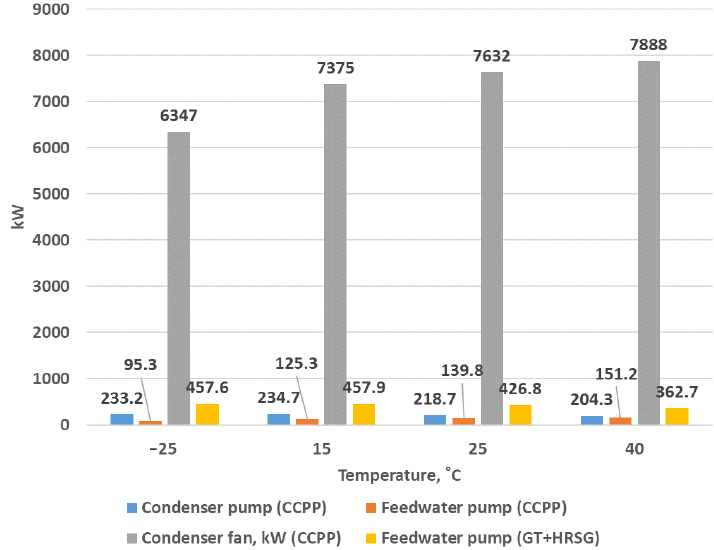
Figure 8. Power consumption by auxiliary equipment of schemes.